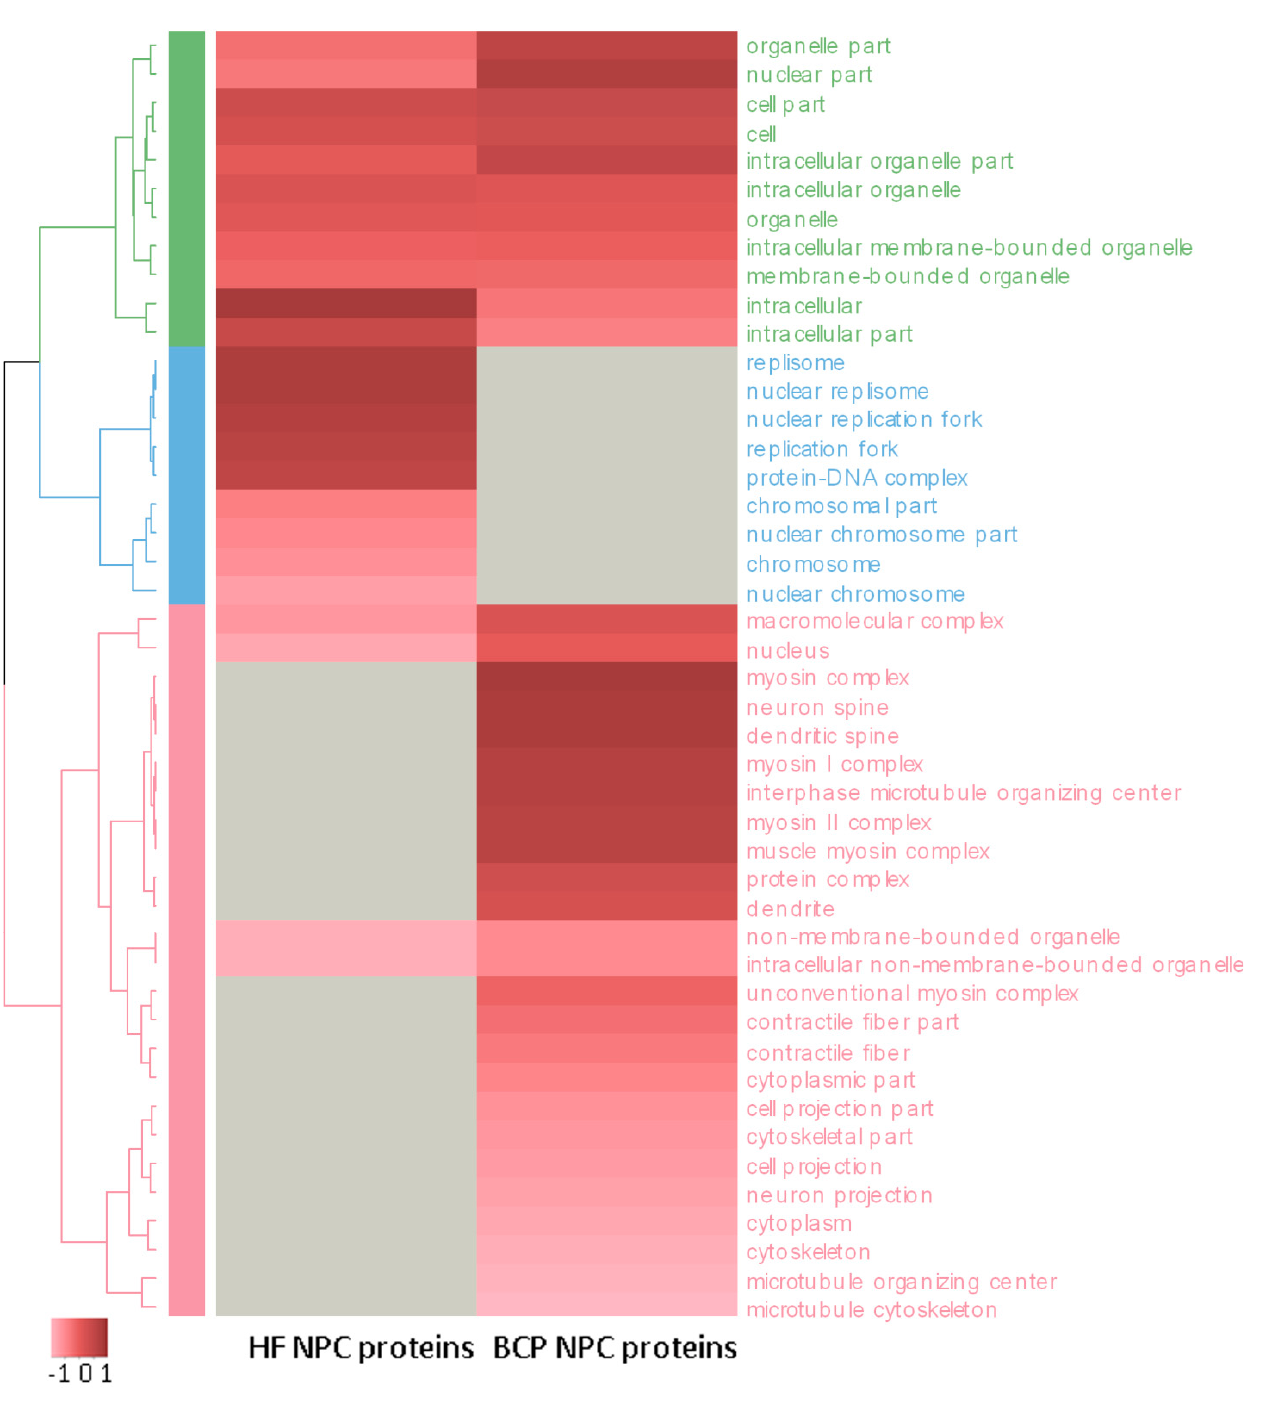
Figure 5. Heat map and dendrogram of the results of GO functional enrichment analysis of NPC proteins from BCPs and HFs by cellular components obtained via STRING via STRING (https://string-db.org/, accessed on 1 March 2023) and visualized using R (https://www.r-project.org/, accessed on 1 March 2023). GO results with p < 0.05 are shown as normalized − log ( p ) values.